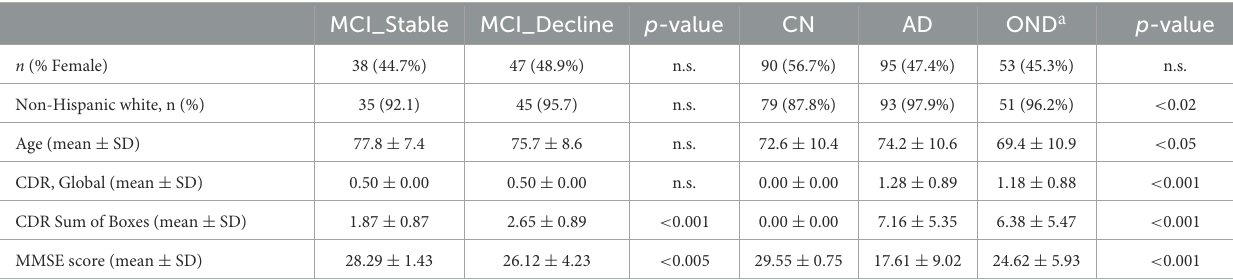
TABLE 2 Demographic and clinical information.